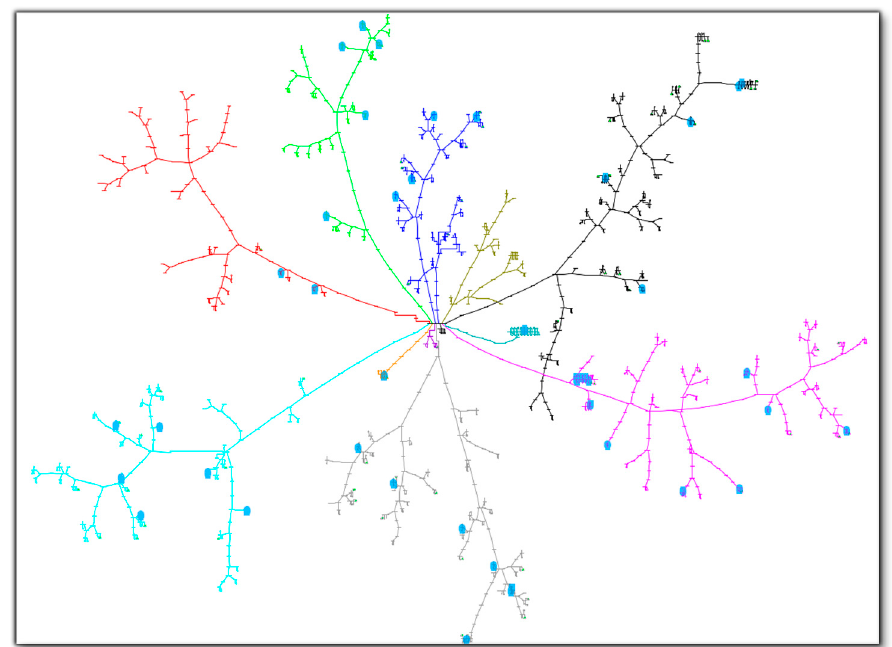
Figure A9. Use case 6—Location of PVs.